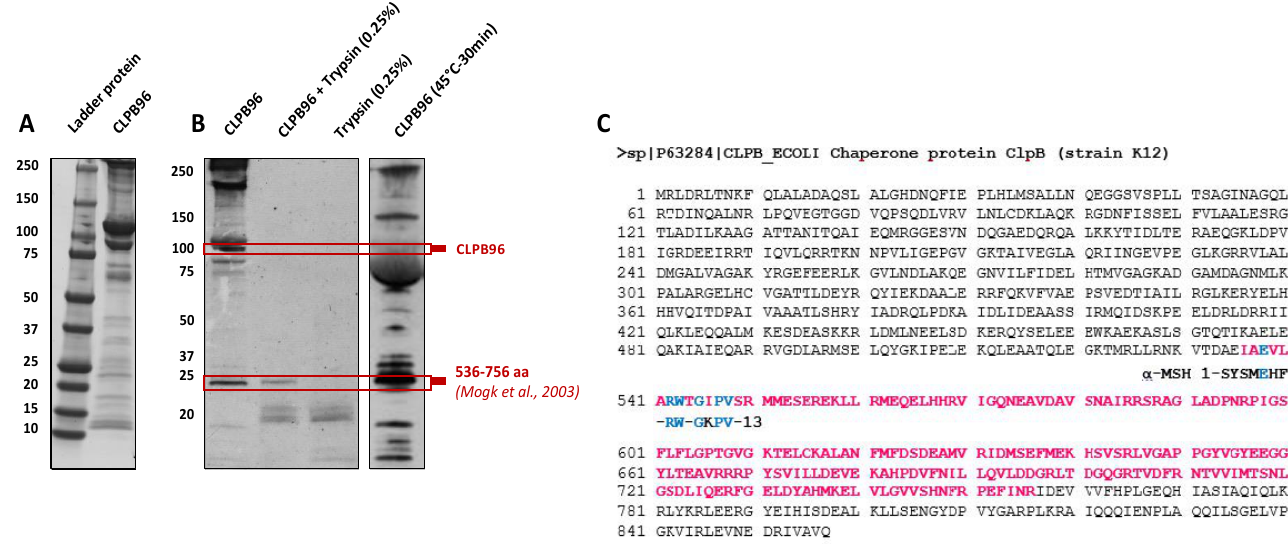
Figure 1. Effects of fragmentation of E. coli WT, E. coli ΔCLPB proteins, and CLPB96 on PYY